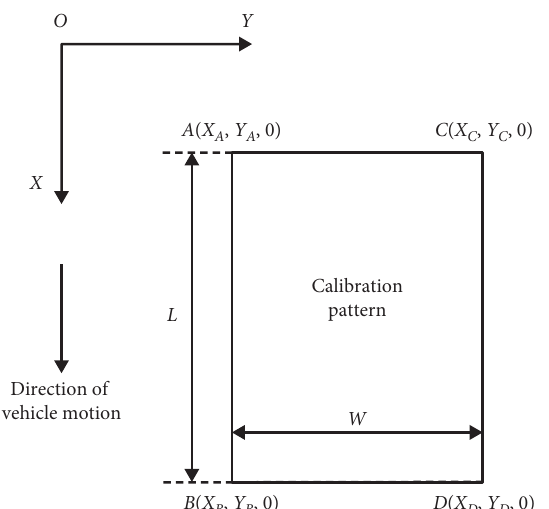
Figure 2: Calibration pattern and its endpoints A , B , C , and D in world coordinates for the method of He and Yung